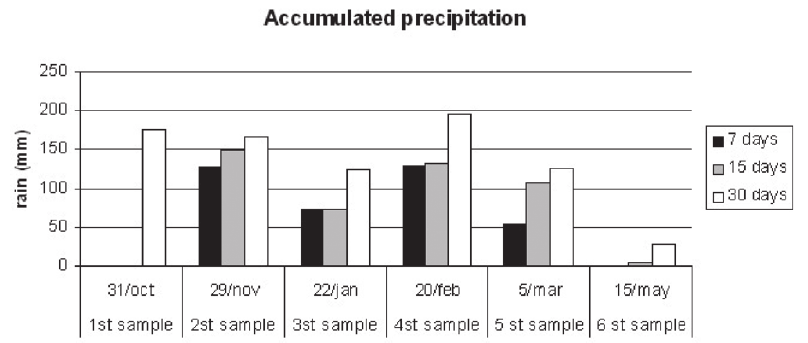
Figure 3 - Accumulated rainfall in the last 7, 15 and 30 days previous to each sampling campaign. Data from: Setor de Climatologia CEPLAC/CEPEC